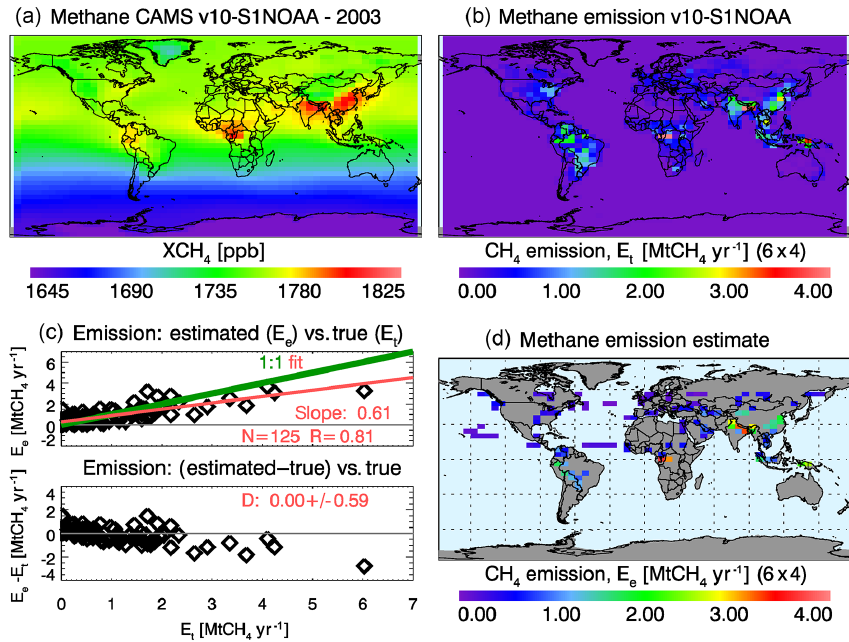
Figure 4. Methane emissions (inMtCH 4 yr − 1 ) and corresponding X CH 4 (inppb) for the year 2003 at 6 ◦ longitude times 4 ◦ latitude resolu- tion. (a) X CH 4 as computed from Copernicus Atmosphere Monitoring Service (CAMS) atmospheric CH 4 fields (version v10-S1NOAA; res- olution: 6 ◦ × 4 ◦ ; obtained from https://atmosphere.copernicus.eu/). (b) Corresponding CAMS total, i.e. anthropogenic and natural, methane emissions. (d) Methane emissions of (automatically determined potential) emission hotspots (“hotspot cells”) as derived from the top left X CH 4 map using the method described in Sect. 3. (c) Comparison of retrieved emissions (map bottom right) with the “true” CAMS emis- sions (map top right). Here N ( = 125) denotes the number of grid cells for which emission values have been obtained (“hotspot cells”; see main text for details), R ( = 0.81) is the linear correlation coefficient of retrieved and true emissions, and D is the difference between the retrieved and the true emissions in terms of mean difference and standard deviation (0.00 ± 0.59 MtCH 4 yr − 1